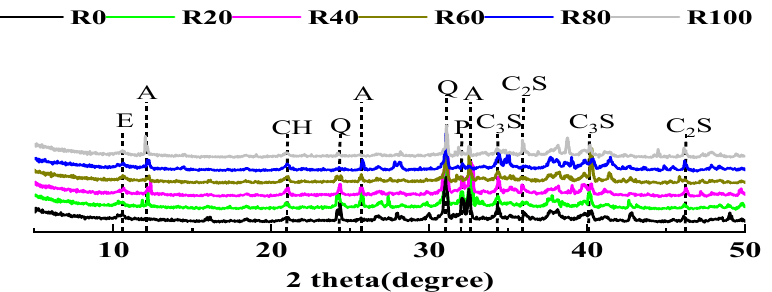
Figure 9. XRD patterns of MUHPC (A: albite; CH: portlandite; C 2 S: dicalcium silicate; C 3 S: tricalcium silicate; E: ettringite; P: potash feldspar; Q: